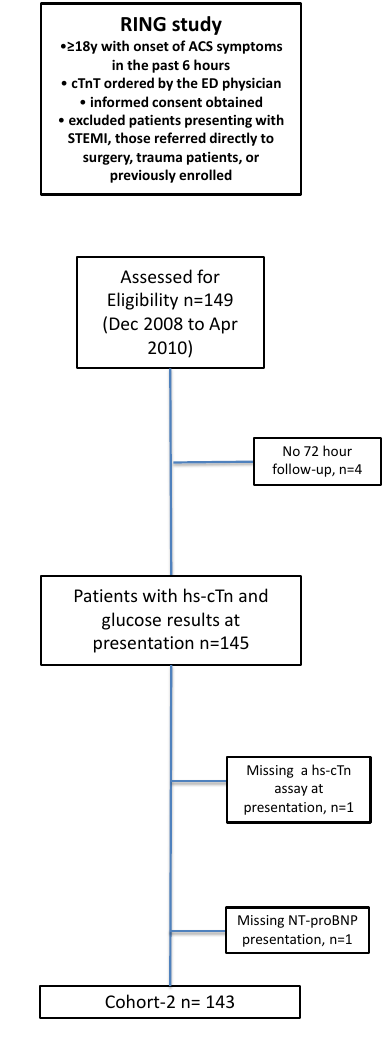
Figure 1. Flow diagram of cohorts used in this study.